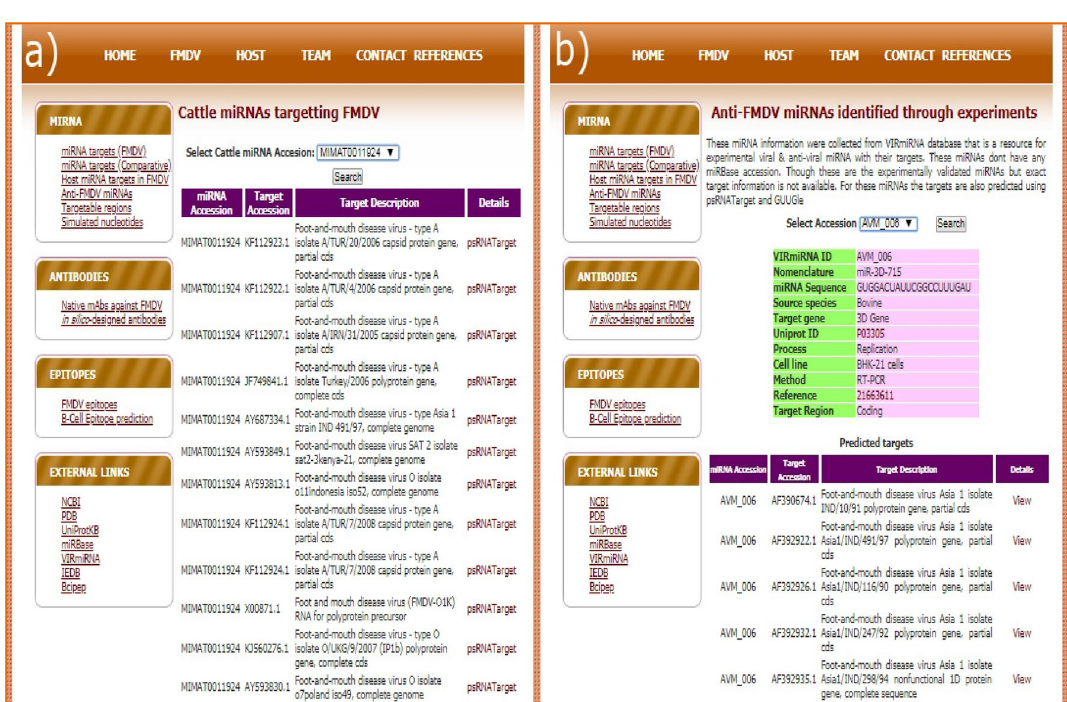
Figure 5. Search interface for host miRNA targets for ( a ) miRBase and ( b ) VIRmiRNA anti-FMDV